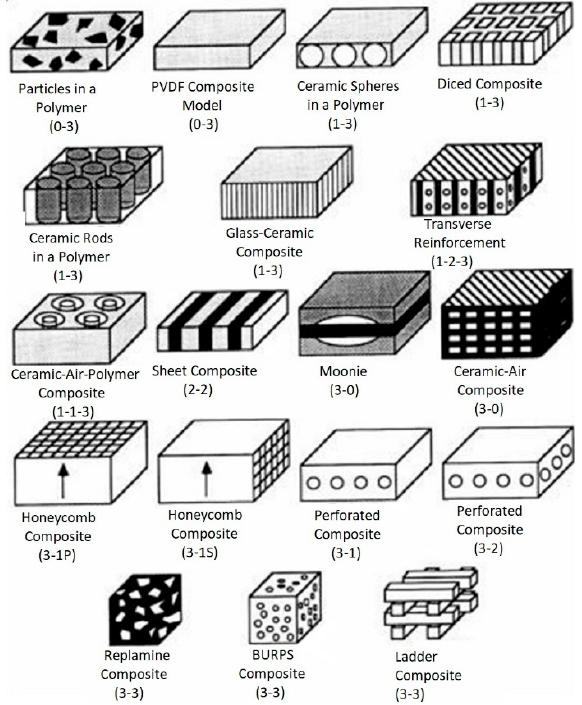
Figure 7. The examples of piezoelectric composites based on the diphasic connectivity concept (Reprinted from Ref. [48], copyright (2016), with the kind permission of Elsevier Ltd. and Techna Group S.r.l.).